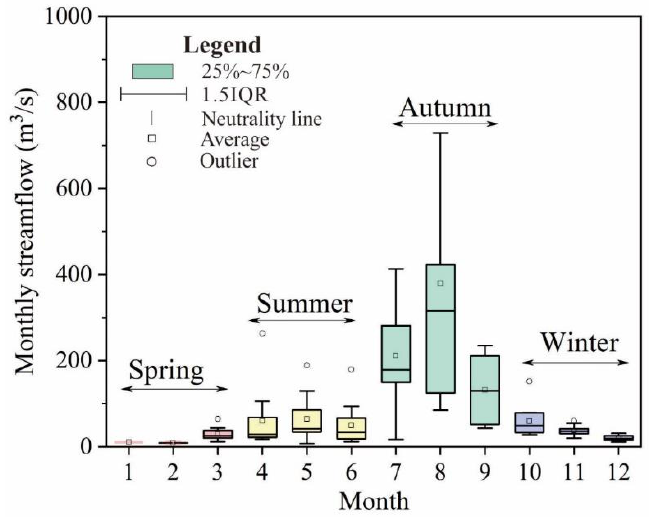
Figure 2. Monthly Streamflow distribution of Liaoyang station before the construction of SWR.